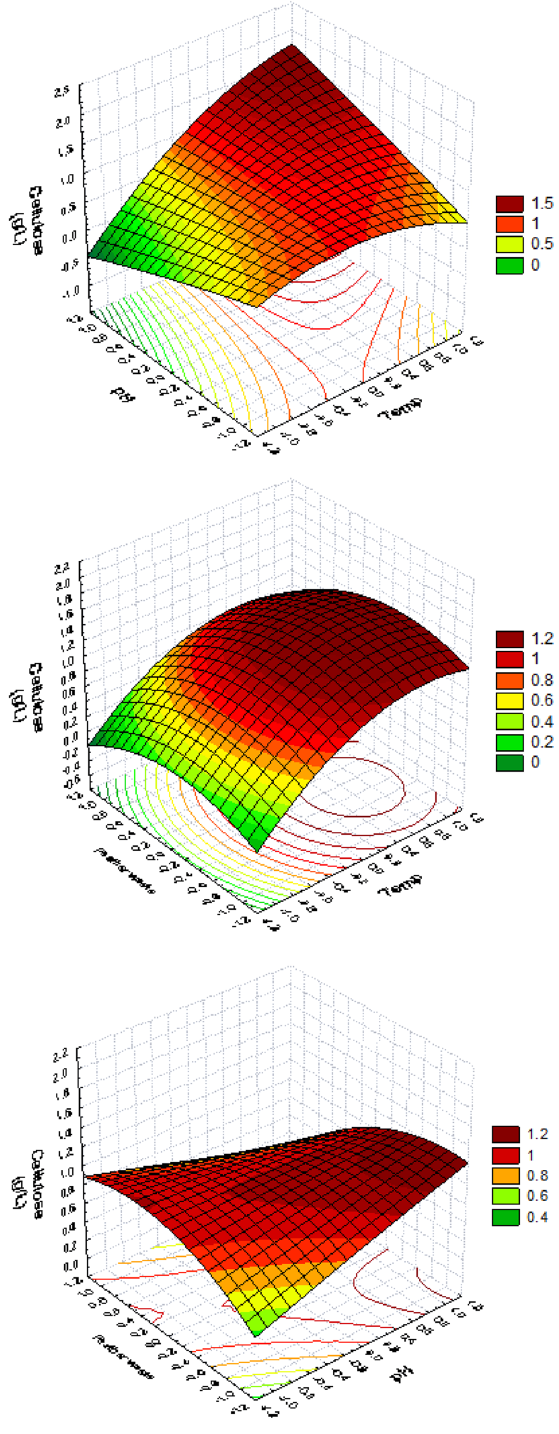
Figure 3. Temperature (X1), pH (X2) and EDCFs (X3) implications on BC production are shown in a 3D response surface and contour